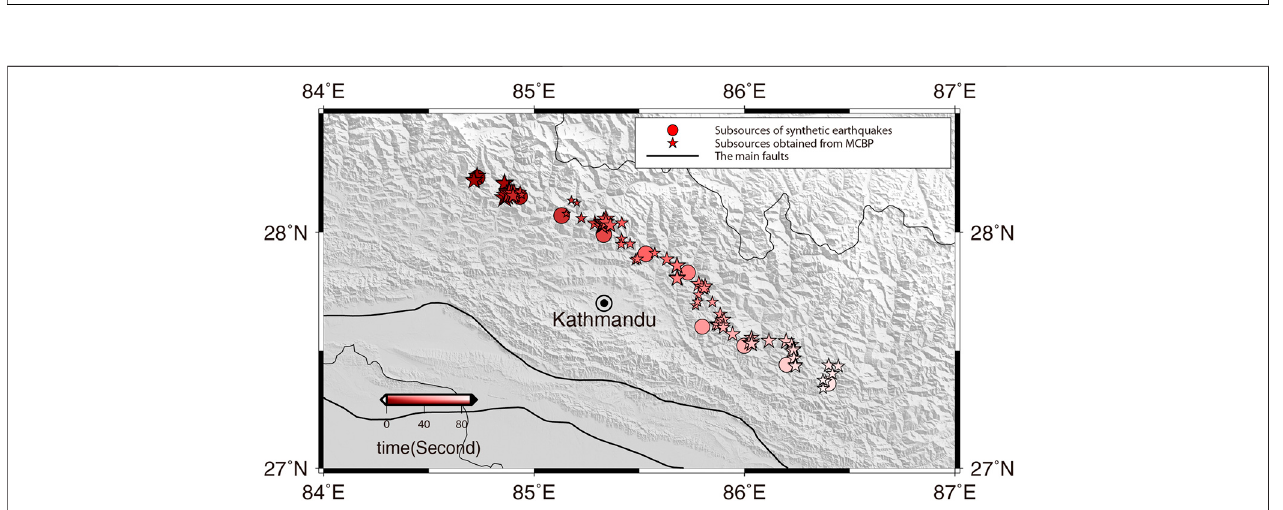
FIGURE 5 | Numerical test results of different arrays obtained by relative back-projection.